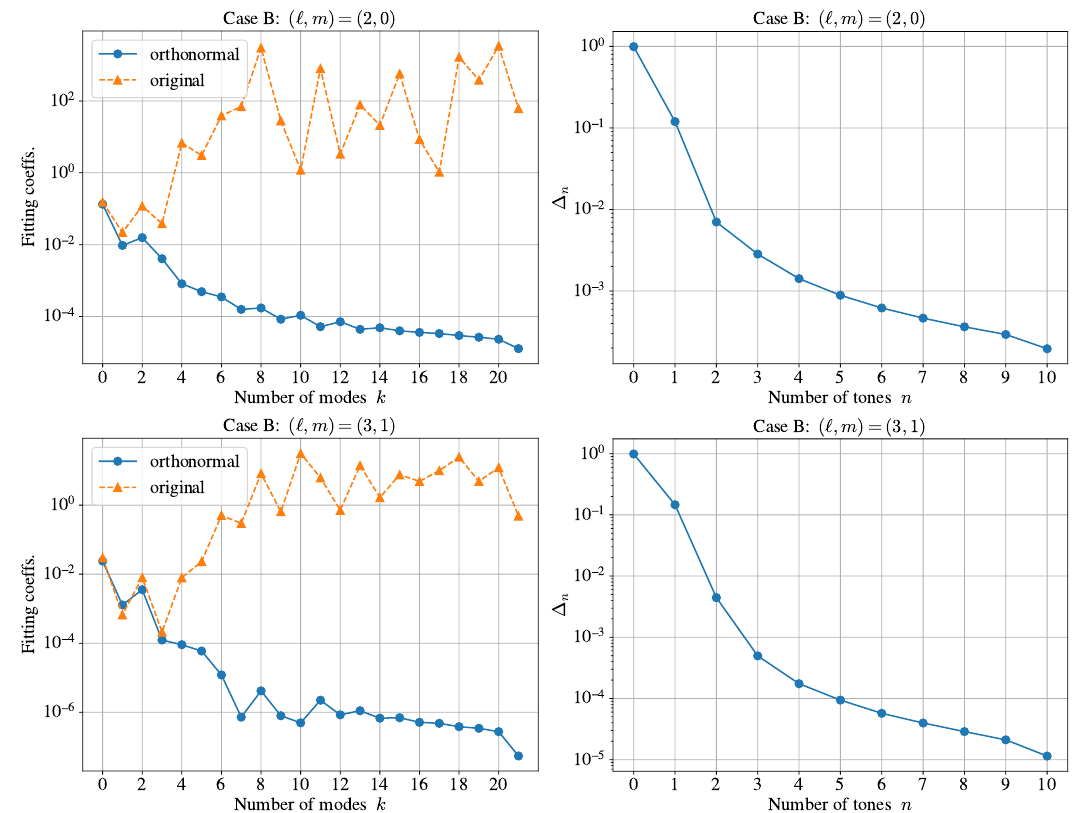
Figure 7. The same figure as for Figure 6, but using the ( (cid:96) = 2, m = 0 ) mode ( top ) and ( (cid:96) = 3, m = 1 ) mode ( bottom ) in case